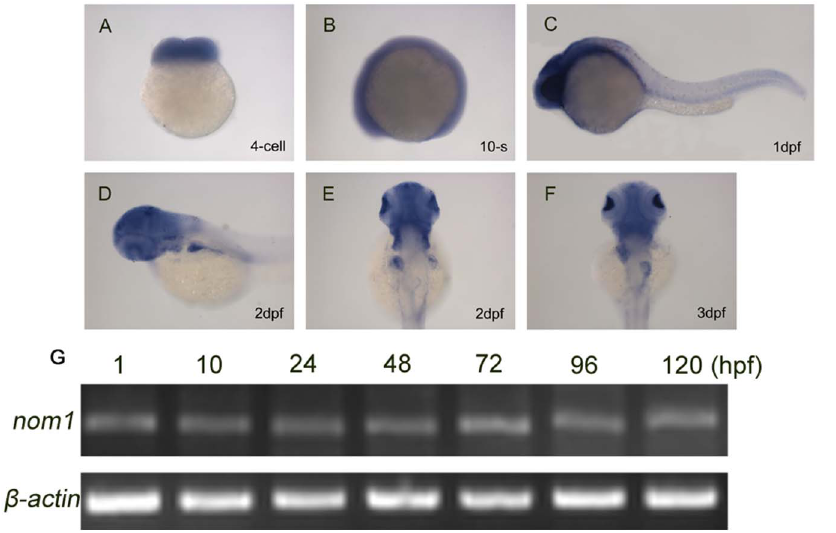
Figure 3. Nom1 expression in the developing zebrafish. (A–D) Lateral views, anterior to the left. (E, F) Dorsal views, anterior to the top. (A) nom1 has a strong maternal expression at 4-cell stage. (B–C) Non-specific ubiquitous nom1 expression is evident at 10-somite stage and 1 dpf. (D, E)